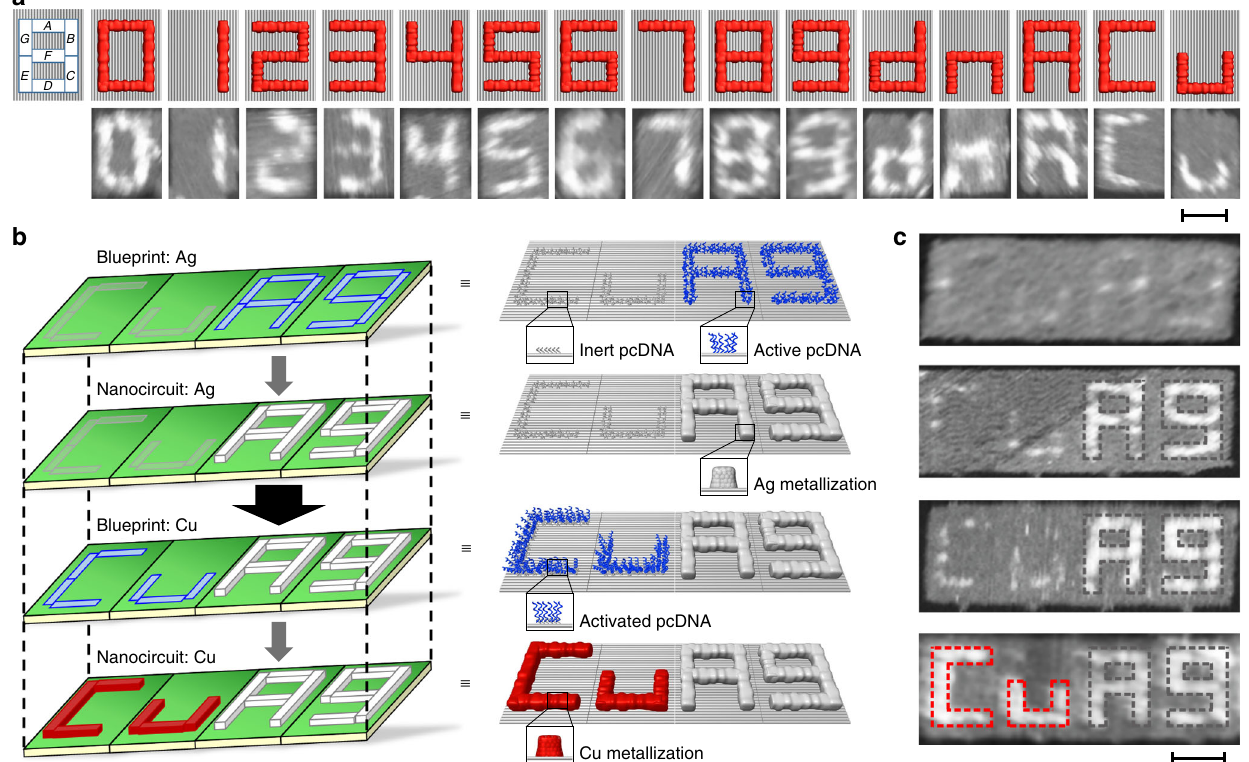
Fig. 4 Fabricating nano-PCB mimics with DCIMP. a A seven-segment digit 8 design is employed to fabricate nano-PCB mimics on a rectangular origami. To show the generality, we fabricated digits from 0 to 9 and several typical alphabets, as shown in corresponding AFM images. b Schematic illustration of the fabrication process of Cu-Ag bi-metallic nanocircuits. c AFM characterization of the Cu-Ag bi-metallic sample prepared at different stages. The size of the integrated panel is 100 × 280 nm 2 . Scale bars: 50